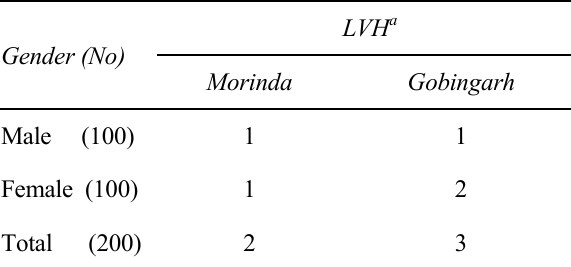
Table 9(c) : Prevalence of Left Ventricular Hypertrophy (LVH) in the populations of the two study